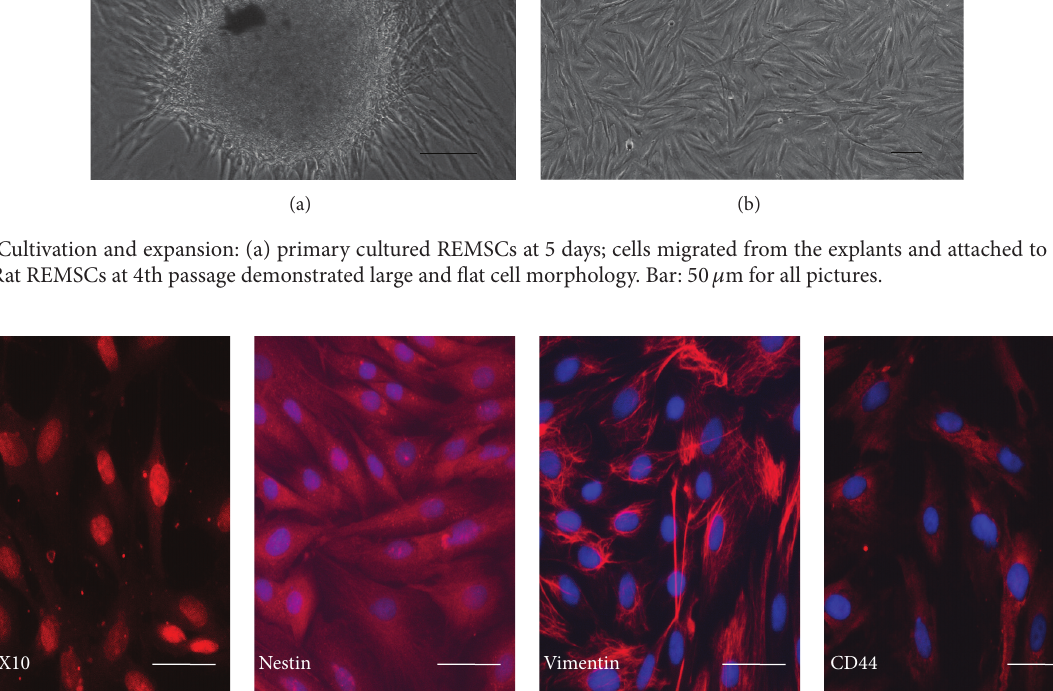
The expression level of each protein was expressed as the ratio of the expression level of the marker protein to 𝛽